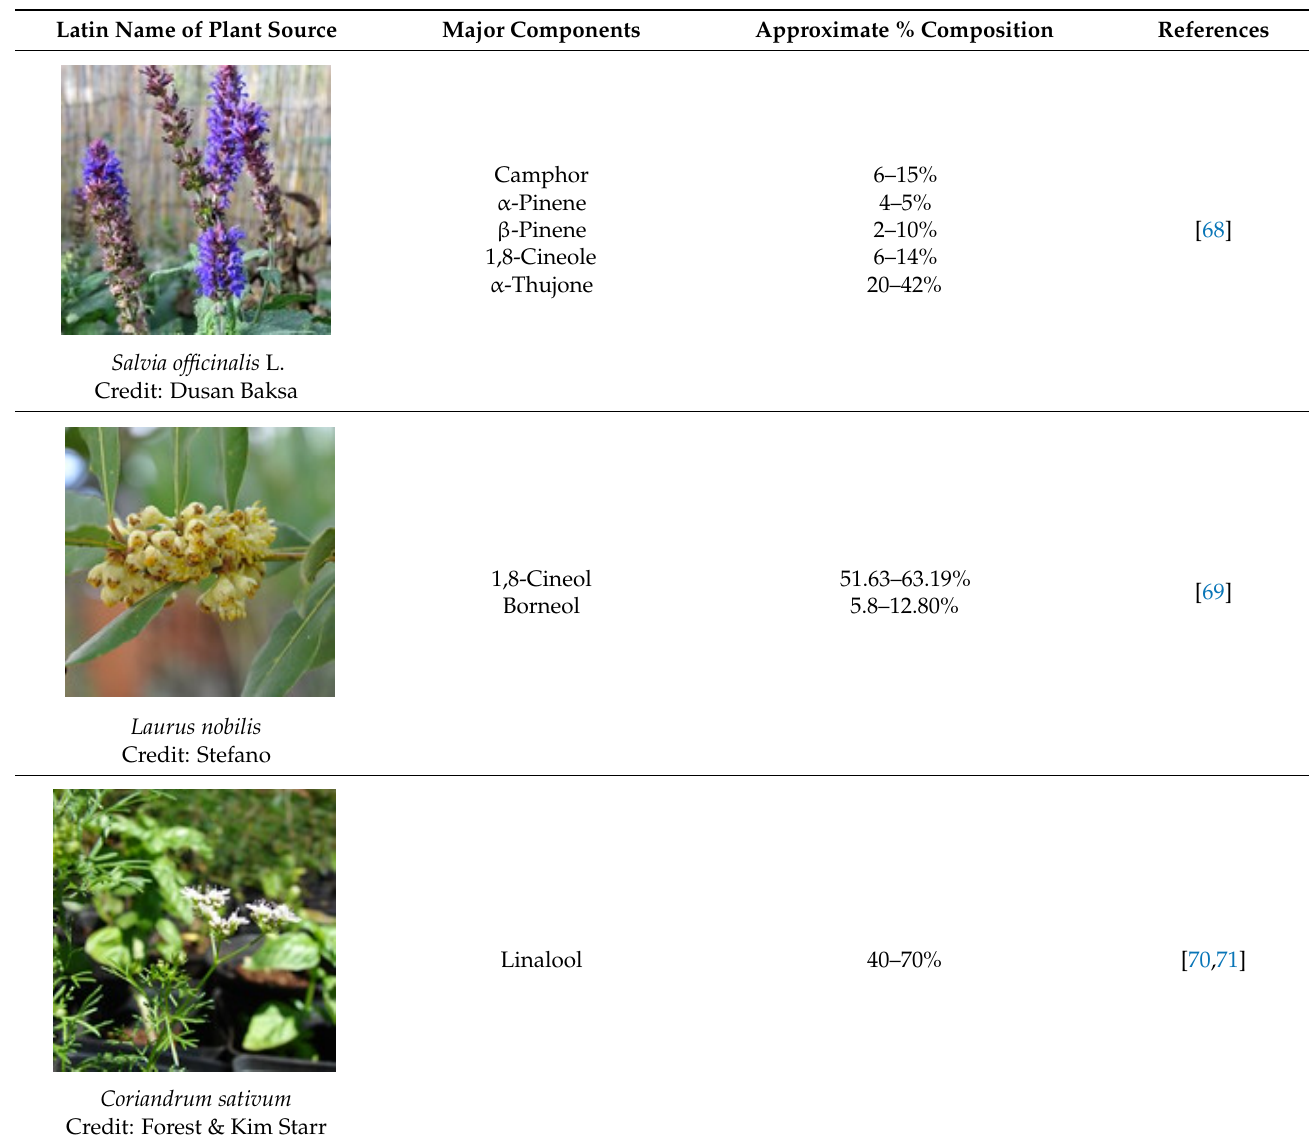
Table 1. Major components of selected essential oils (EOs) that exhibit antibacterial properties. Latin Name of Plant Source